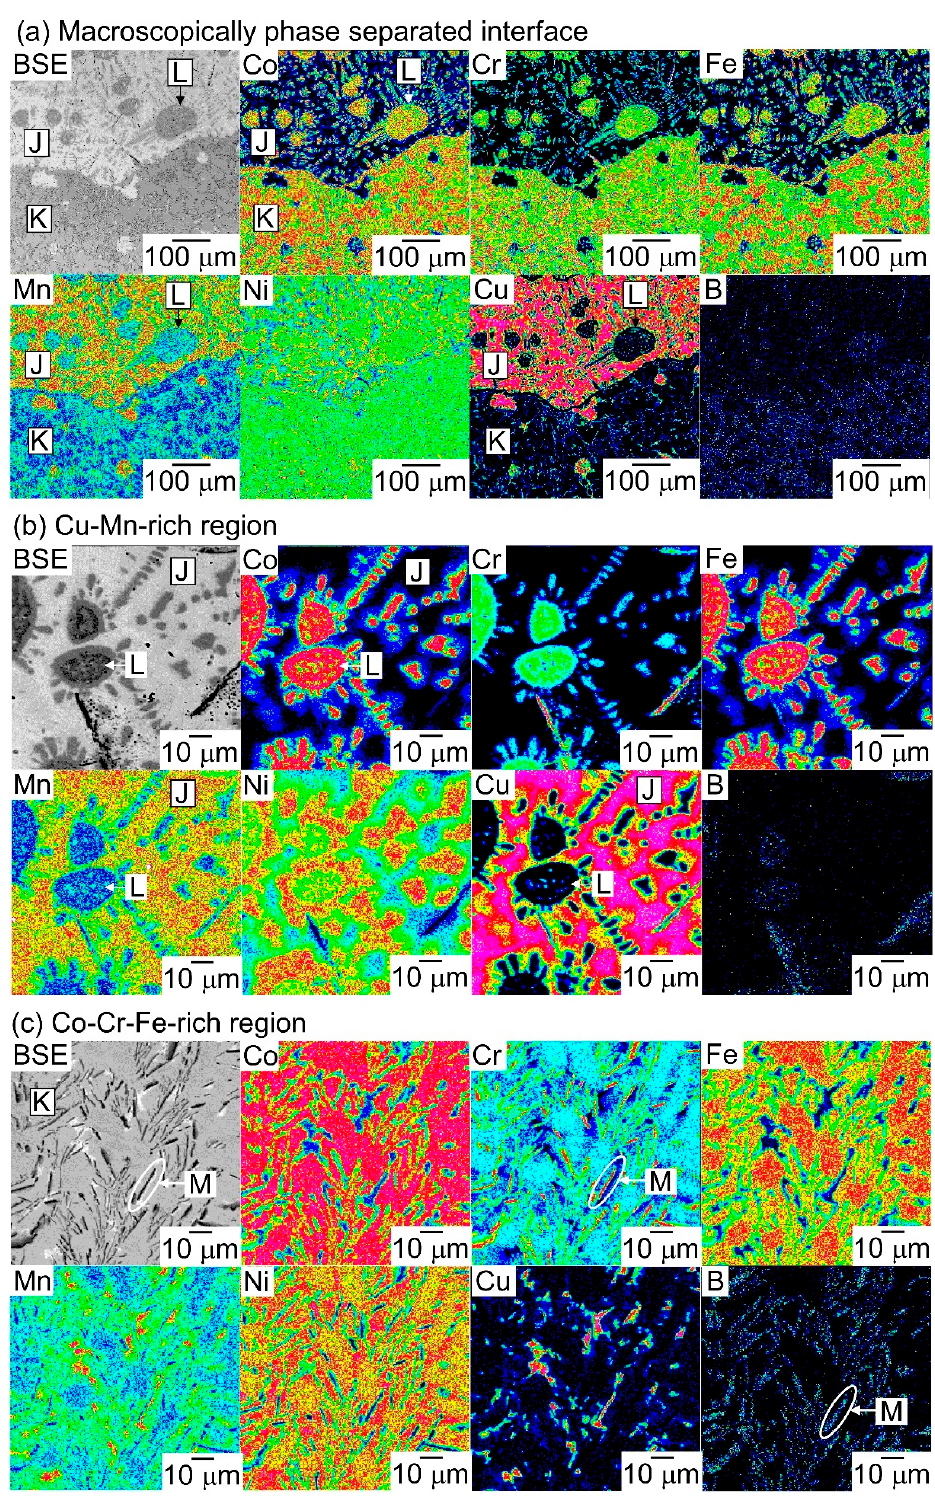
Figure 11. Element mapping of the arc-melted ingots of the B-added CoCrCu 2 FeMnNiB 0.2 (Cu2B02) HEA with a macroscopic phase-separated structure analyzed using EPMA-WDS, as the typical example of the solidification microstructure of Co-Cr-Cu-Fe-Mn-Ni-B HEAs with a macroscopically phase-separated structure. ( a ) Element mapping focusing on the macroscopically phase-separated interface, ( b ) element mapping focusing on the Cu-Mn-rich region (J in Figure 11a), ( c ) element mapping focusing on the Co-Cr-Fe-rich region (K in Figure